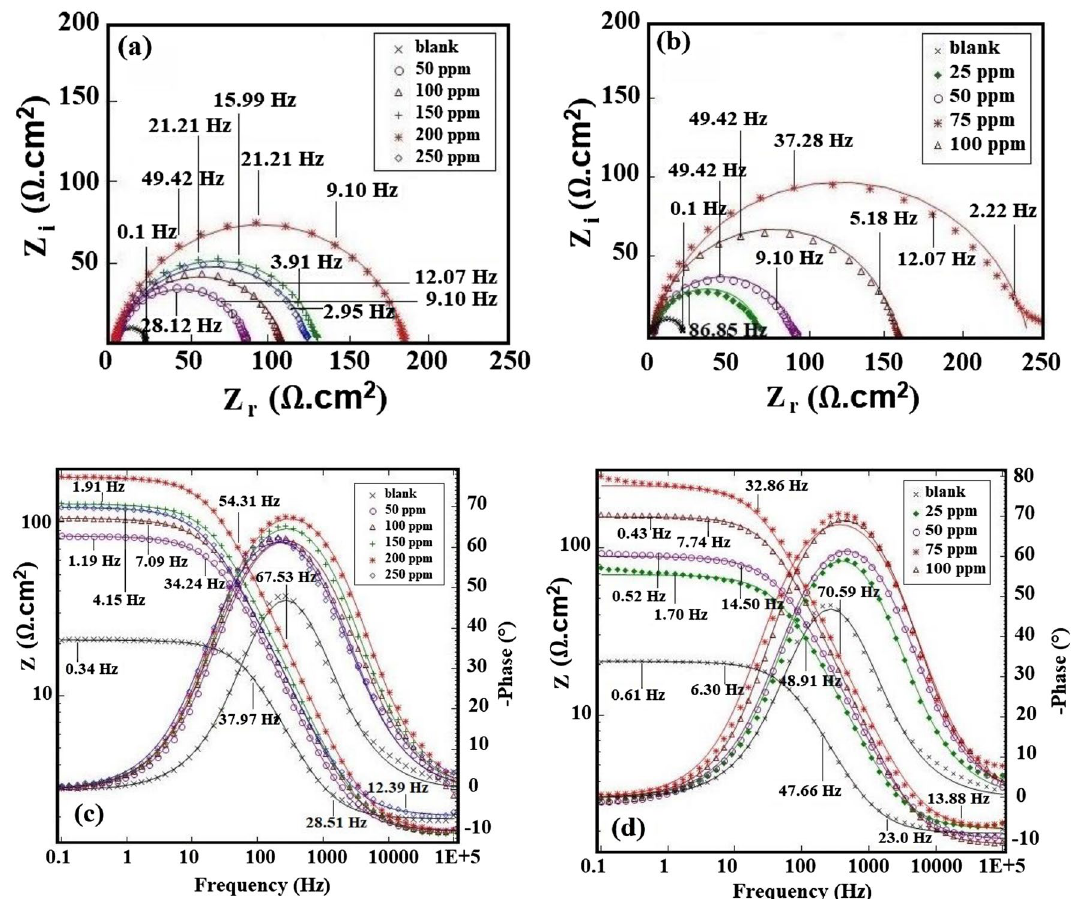
Figure 3. The ( a , b ) Nyquist plots, ( c , d ) bode plots, and phase angle plots for st-37 with different concentrations of Dracocephalum based on bulk, and nano size, in 0.5 M H 2 SO 4